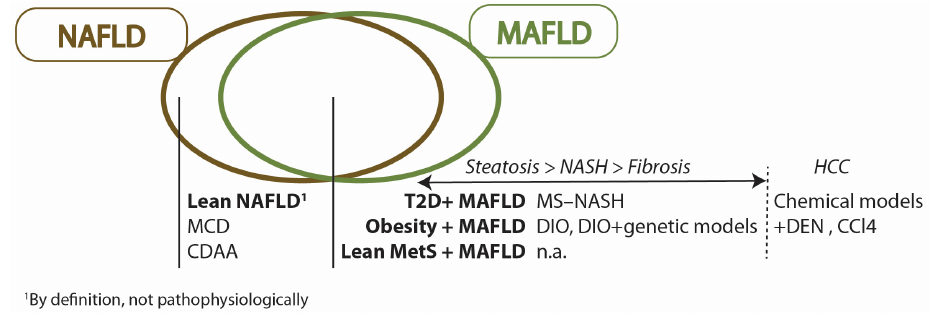
Figure 4. Preclinical MAFLD models in the NAFLD-MAFLD